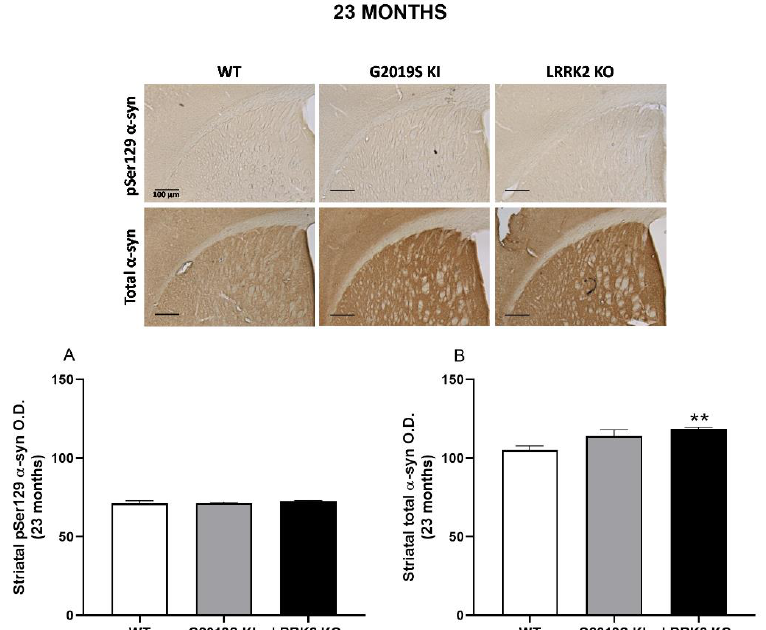
Figure 9. α -synuclein levels are elevated in the striatum of 23-month-old LRRK2 KO mice. Immuno- histochemistry in the striatum of 23-month-old G2019S KI and LRRK2 KO mice in comparison with age-matched WT mice. Optical density (O.D.) of pSer129 α -syn ( A ) and total α -syn ( B ) immunostain- ing was quantified. Data are expressed as mean ± SEM of n = 10 WT mice, n = 8 G2019S KI mice and n = 9 LRRK2 KO mice. Representative images were provided in the upper panels (scale bar =100 µ m). Statistical analysis was performed by ANOVA followed by the Tukey test for multiple comparisons. ** p < 0.01 different from WT